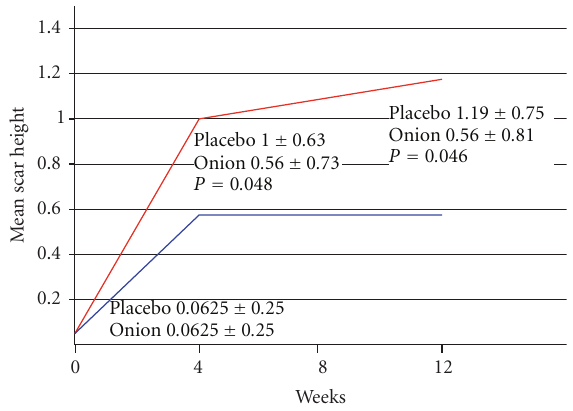
Figure 3: This figure demonstrates mean scar height on the placebo compared to the treatment side. A statistically significant di ff erence favoring the treatment side was found at the 4th and 12th week follow-up. Red and blue line represents placebo and treatment side, respectively.